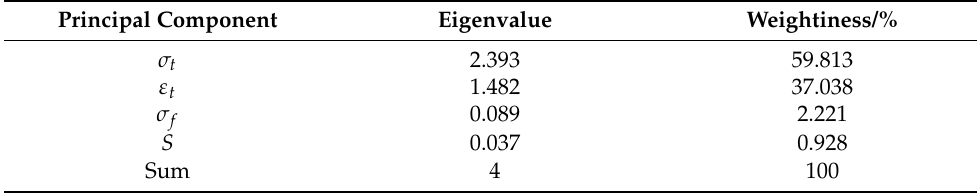
Table 5. Weightiness of